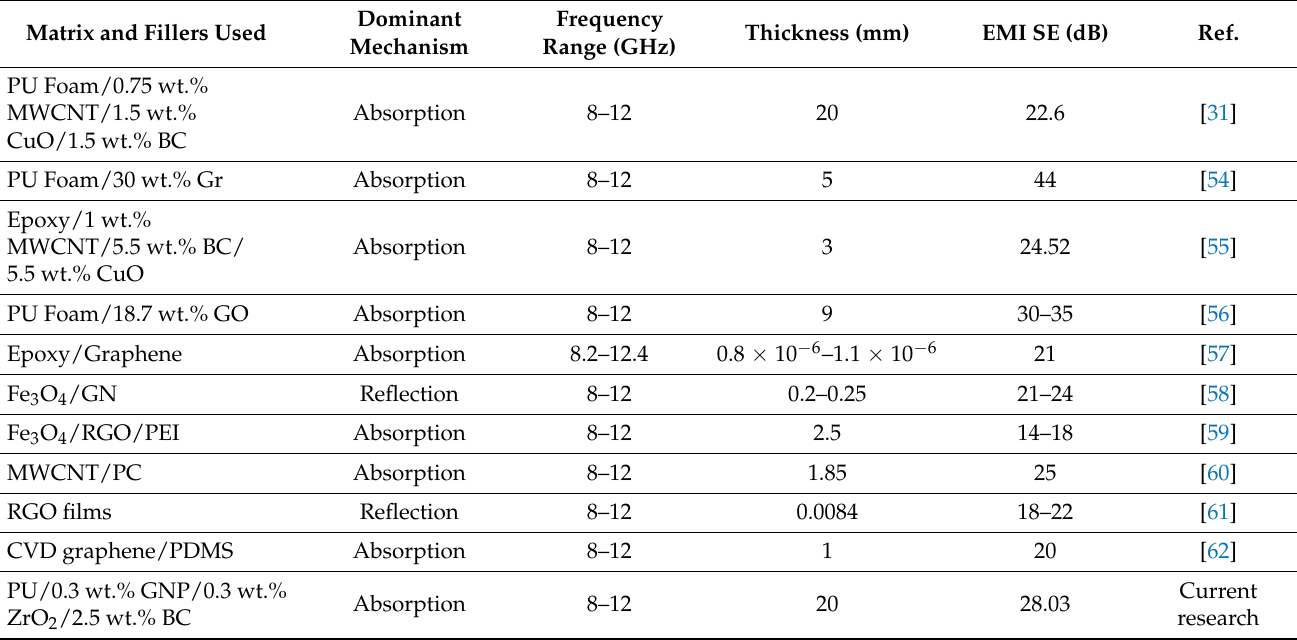
Table 10. Performance of EMI SE based on materials, dominant mechanism, frequency range, and thickness.